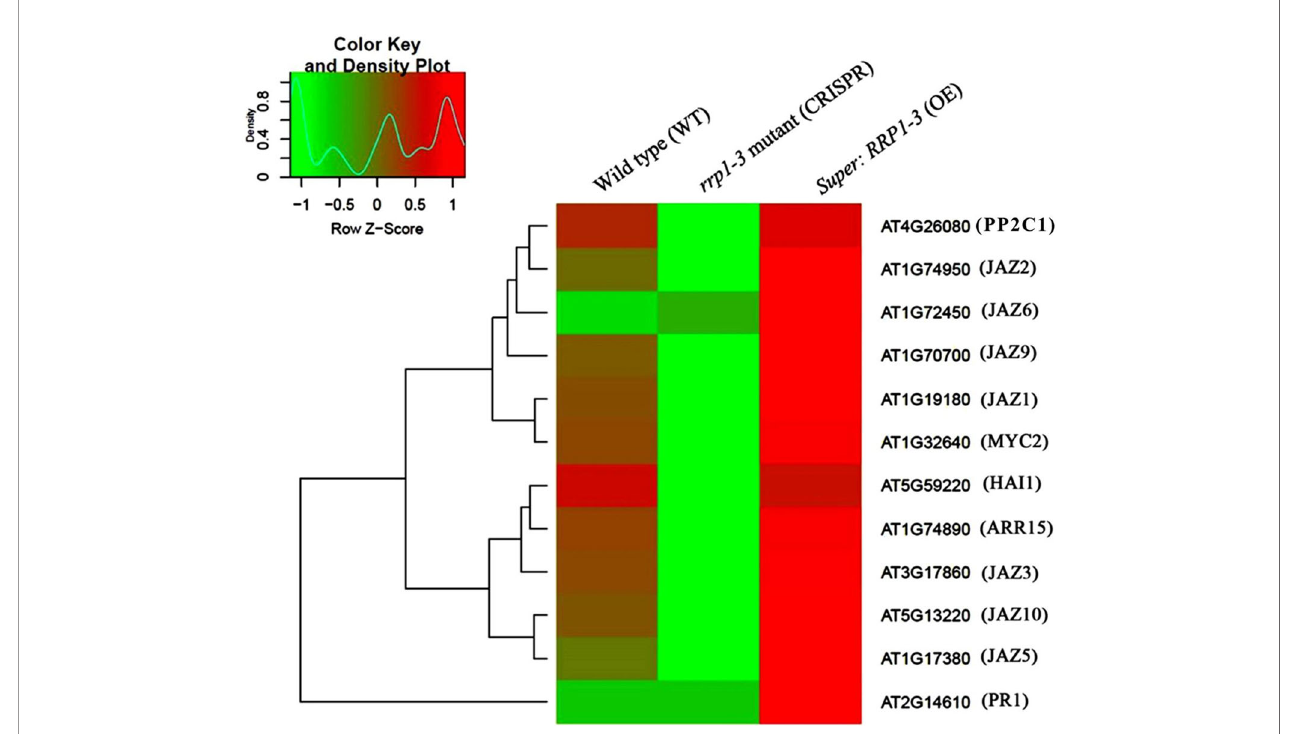
FIGURE 4 | Heatmap and cluster analysis of transcripts for the important genes associated with RRP1 in Arabidopsis . Data for gene expression levels were normalized to the z -score with the formula log 10 (FPKM + 1) and are indicated by a color key and density plot; from green to red represents a relative gene expression level from low to high, respectively. ABI1, ABA-insensitive 1; HAI1, highly ABA-Induced1; JAZ1, 2, 3, 5, 6, 9, and 10, Jasmonate ZIM-domain1, 2, 3, 5, 6, 9, and 10; MYC2, myelocytomatosis protein 2 (a basic helix-loop-helix Leu zipper transcription factor); ARR15, two-component type-A response regulator; and PR1 (pathogenesis-related protein